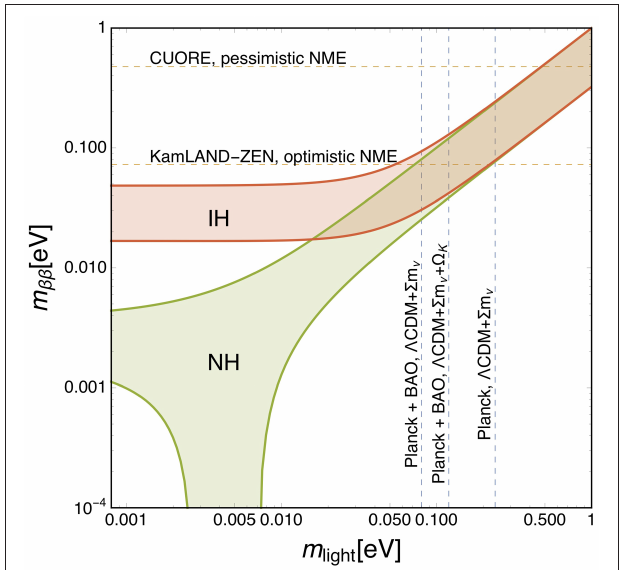
FIGURE 6 | The same as Figure 5 , but for future cosmological observations and 0 ν 2 β experiments. Note that in this figure we show 95% upper limits for FIGURE 5 | Majorana mass m ββ of the electron neutrino as a function of the both m ββ and m light , assuming that the true values of both quantities are mass m light of the lightest neutrino eigenstate, for normal (green) or inverted much smaller that the corresponding experimental sensitivities. The horizontal (red) hierarchy. The filled regions correspond to the uncertainty related to the yellow band labeled “Future 0 ν 2 β ” is the union of the regions that contain the CP-violating phases. The horizontal dashed lines show 95% current upper 95% upper limits for LEGEND 1K, CUPID, and nEXO, assuming 5 years of live limits from 0 ν 2 β searches. In particular, we show the tightest and loosest limits time. The vertical dashed lines correspond to 95% upper limits on 6 m ν . From among those reported in the text, namely the most stringent from 6 m ν model, CORE TT, TE, right to left: CORE TT, TE, EE, PP in the 3 CDM + KamLAND-Zen (labeled “KamLAND-Zen, optimistic NME”), and the less 6 m ν (cid:127) K model, EE, PP the DESI and EUCLID BAO in the 3 CDM + + + stringent from CUORE (labeled “CUORE, pessimistic NME”). NME refers to the 6 m ν CORE TT, TE, EE, PP the DESI and EUCLID BAO in the 3 CDM + + uncertainty related to the nuclear matrix elements. We also show vertical model. The vertical lines shown in the plot assume normal dashed lines corresponding to 95% upper limits on 6 m ν from cosmological observations, translated to upper limits on m light using the information from oscillation experiments. In particular we show different model and dataset 6 m ν model, combinations, from right to left: PlanckTT lowP in the 3 CDM + + 6 m ν (cid:127) K model, PlanckTT lowP BAO in the 3 CDM + + + + 6 m ν model. The vertical lines shown in PlanckTT lowP BAO in the 3 CDM + + + the plot assume normal hierarchy, but the difference with the case of inverted hierarchy is very small on the scale of the plot.